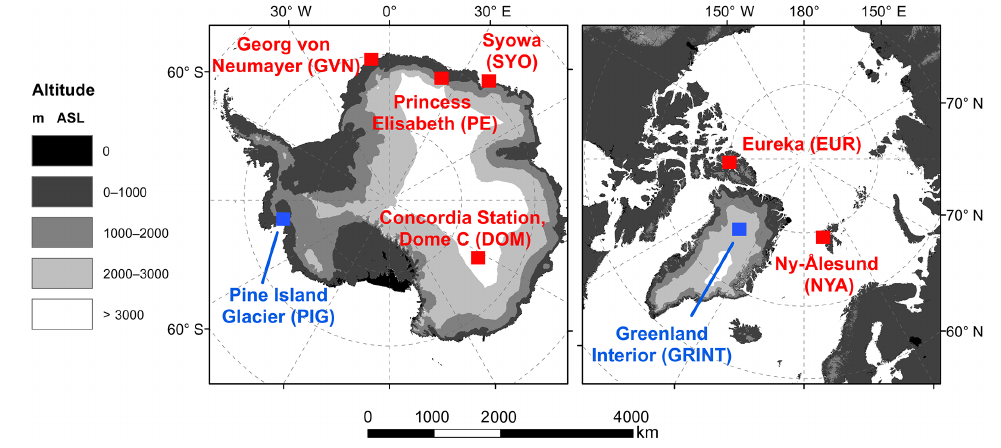
Figure 2. Locations of the six AWSs (red) and two new locations